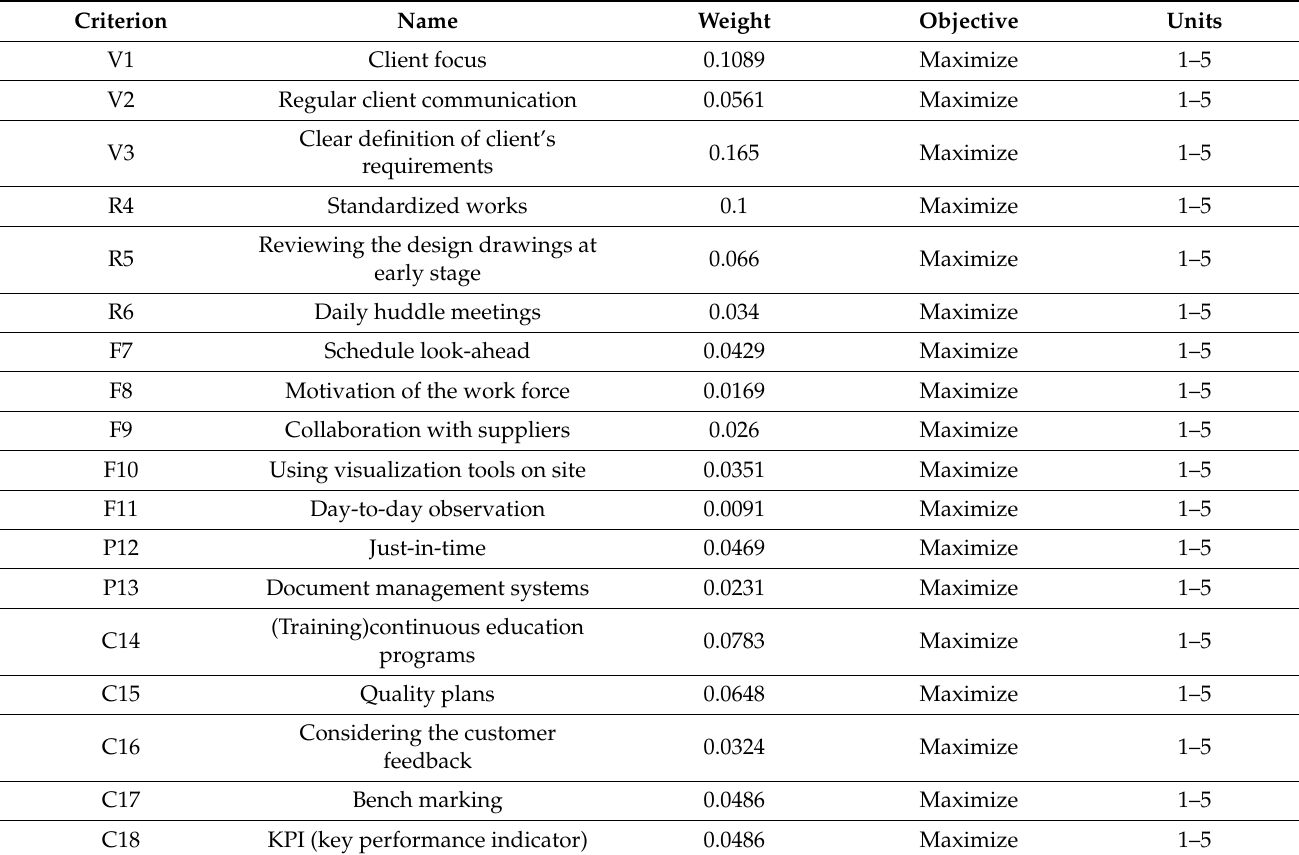
Table 5. The global weight of each driver and the objective for each driver.